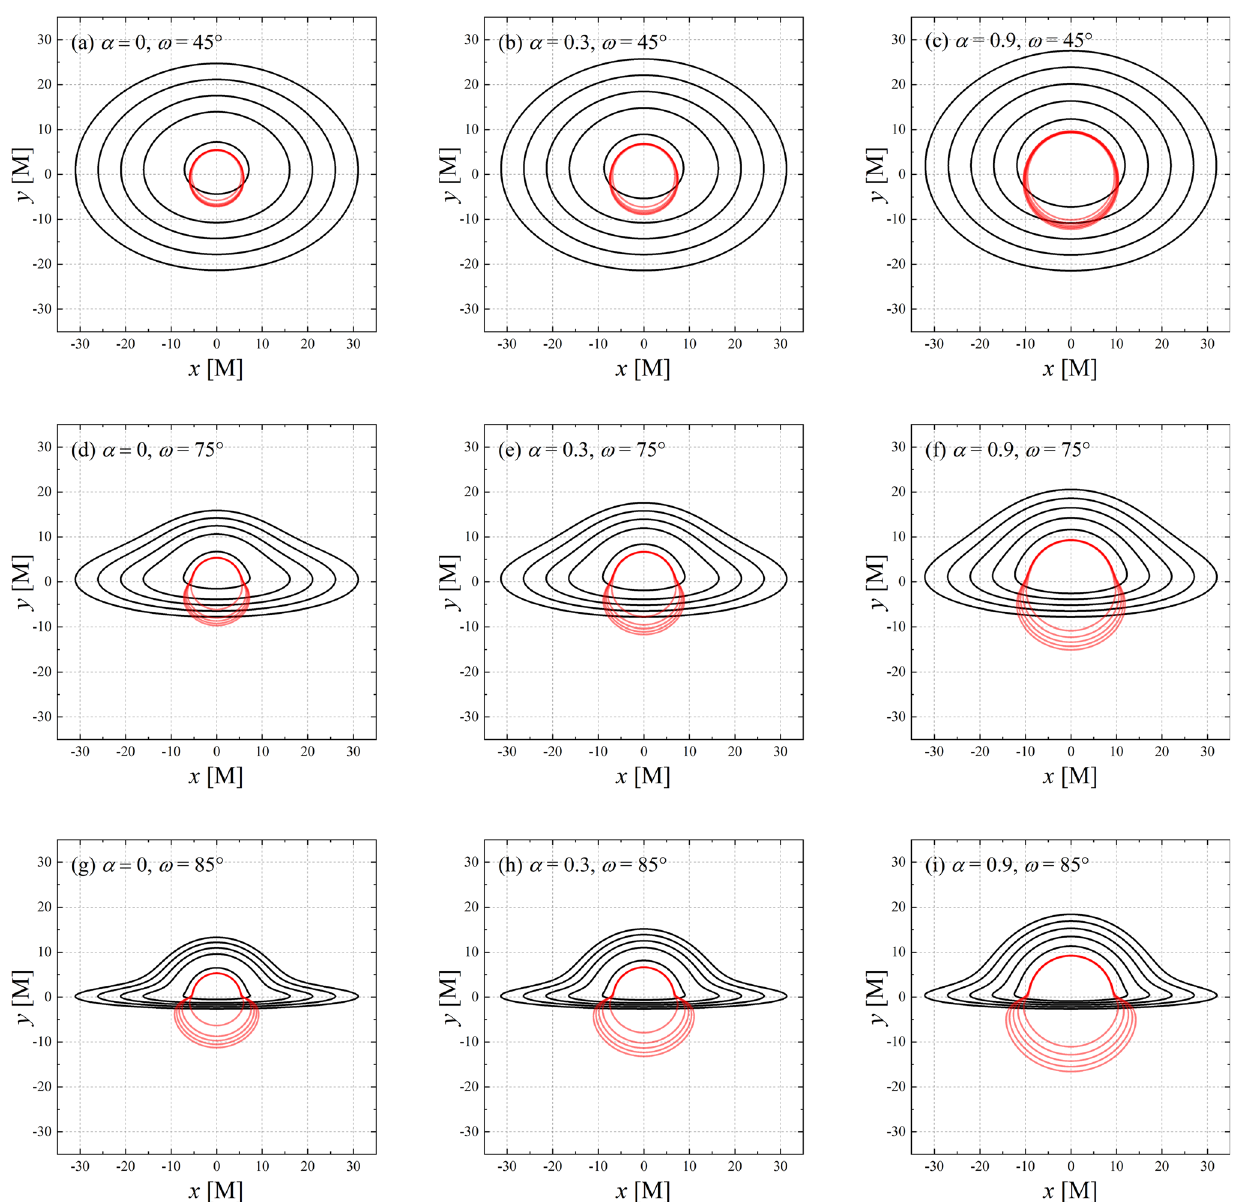
panel outward, the profiles correspond to the stable circular orbit with radii r = r ms , 15, 20, 25, and 30 in